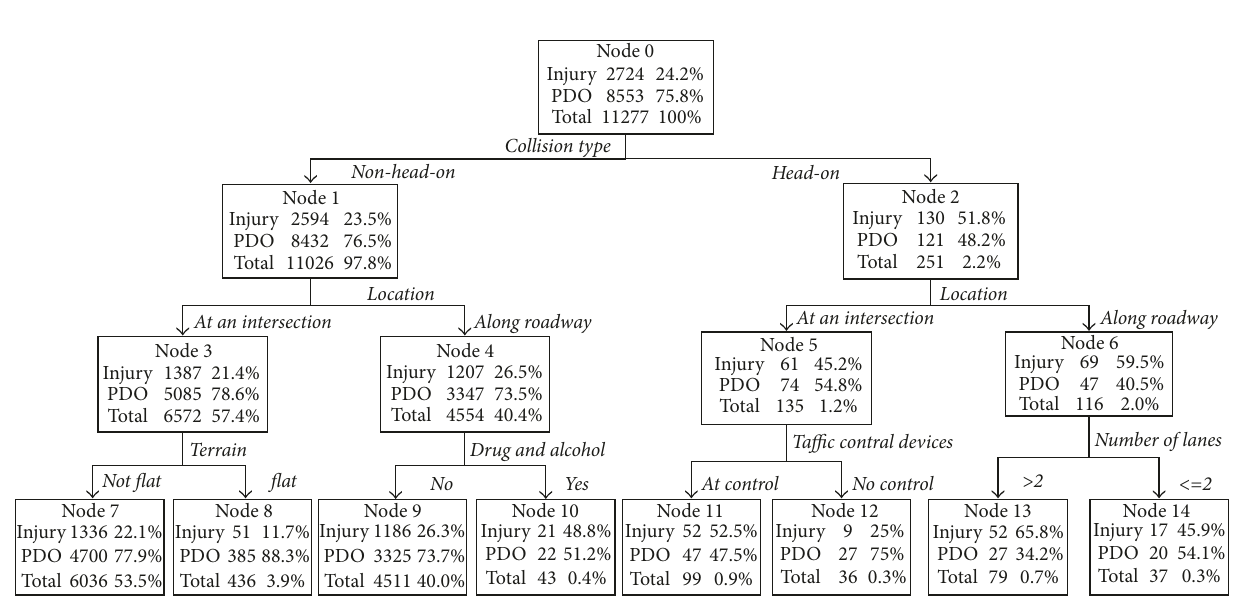
Figure 2: Decision tree under daylight